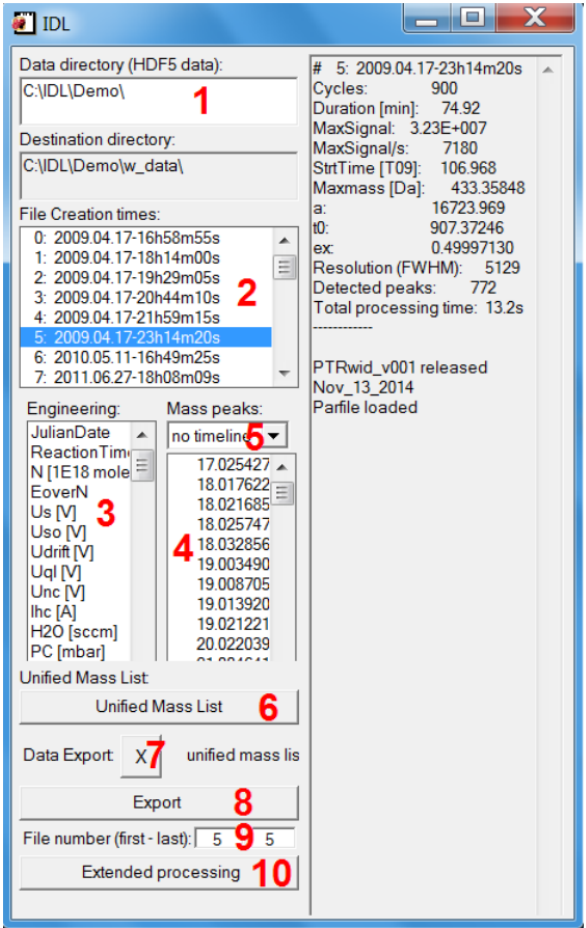
Figure B1. Main PTRwid control window. In the top-left text field the user selects a data directory. The creation times (i.e., start of measurement) of all HDF5 files in the data folder (including sub directories) are listed in the field labeled “file creation times”. In- dividual files can be selected and first processing results are dis- played in the session log on the right hand side of the window. The names of available engineering data and the detected mass peaks of the selected file are displayed in separate lists, respectively. The interactive elements are labeled with bold red numbers and briefly described in Appendix